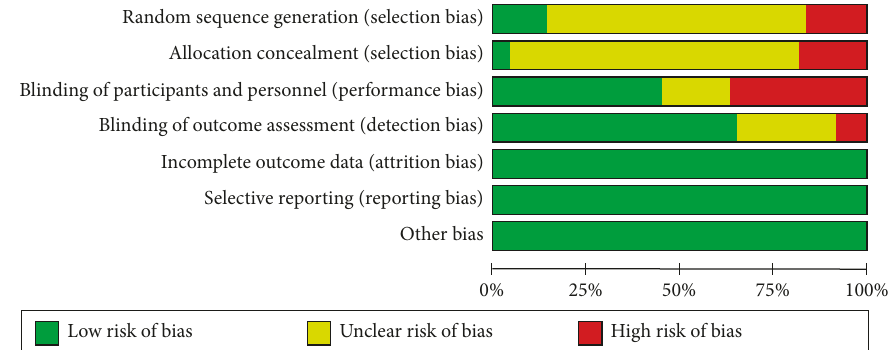
Figure 3: Methodological quality graph: reviewer author’s judgments about each methodological quality item presented as percentage across all included studies.